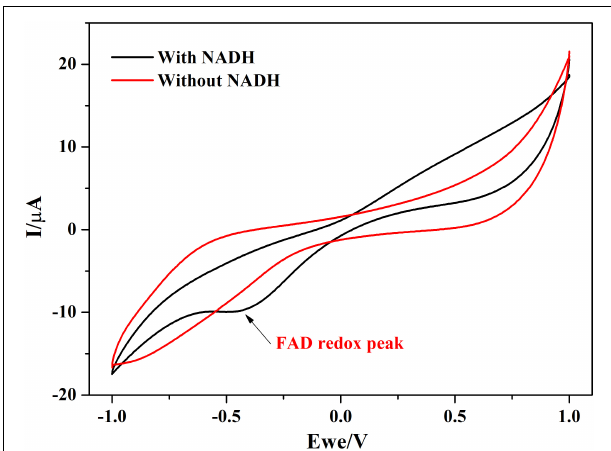
FIGURE 7 | Protein film voltammetry of purified NDH-2 has shown a redox peak at ∼ –225 mV indicating the involvement of FAD cofactor in the enzyme electrode reactions which is also the cofactor present in the